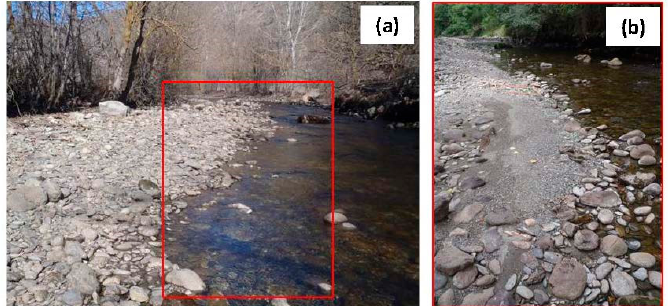
Figure 12. Fine sediment availability in reach R3, downstream from the confluence of the River Unarre (see Figure 1 for locations details). ( a ) General view of the coarse surface layer with a marginal presence of fine after a series of hydropeaks (depletion). The red square illustrates the location of the photo presented in ( b ) where fine sediments transferred and deposited after a flood event can be clearly observed.